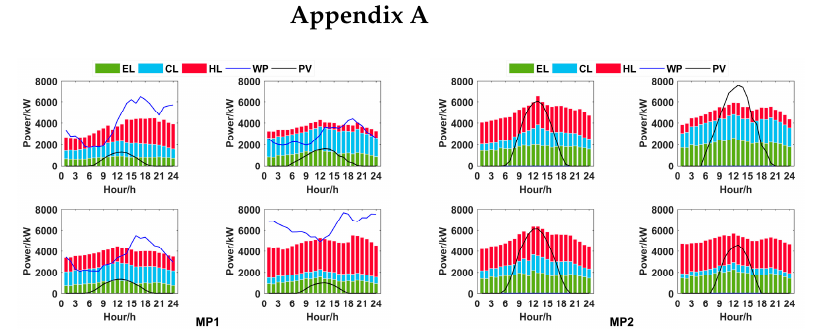
Figure A1. Park load and renewable energy output.